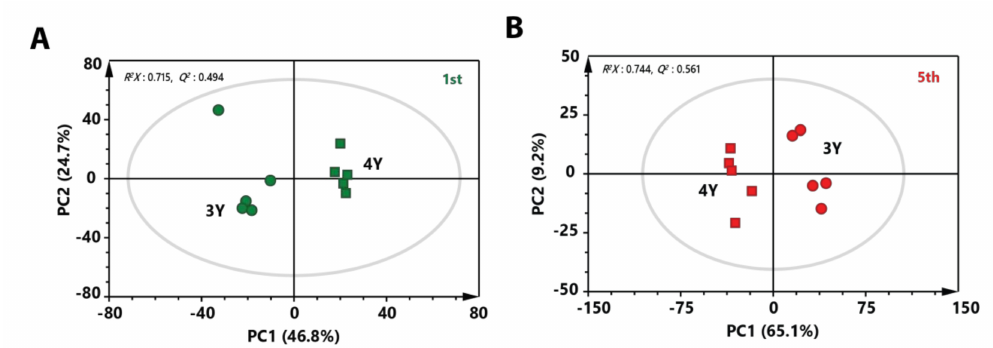
Figure 3. PCA score plot derived from GC-MS data between three-year-old GB and four-year-old GB at ( A ) the first harvest time and ( B ) the fifth harvest time. Circular symbols and rectangular symbols represent three-year-old GB and four-year-old GB, respectively. The color of each symbol is as follows: green color, first-harvested sample; red color, fifth-harvested sample.